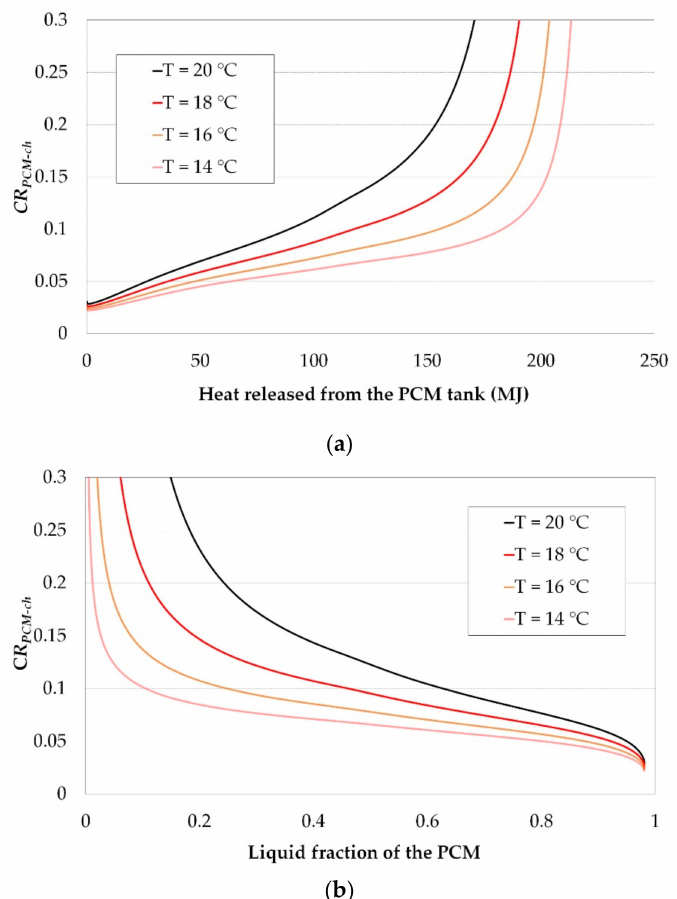
Figure 10. Value of CR in the PCM charge mode against ( a ) heat released from the tank and ( b ) liquid fraction of the